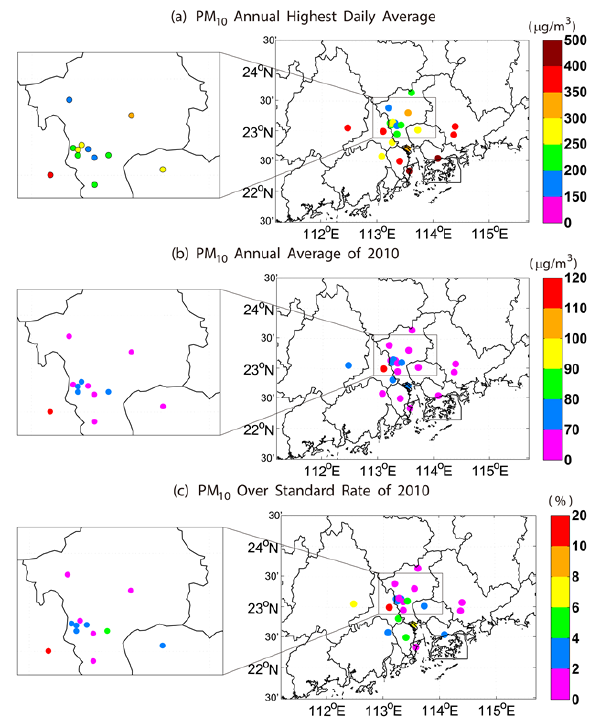
Fig. 4. PM 10 concentration (µg m -3 ) of each of the 22 individual sites in PRD region in 2010 of (a) the annual highest daily average, (b) the annual average and (c) non-attainment rate.